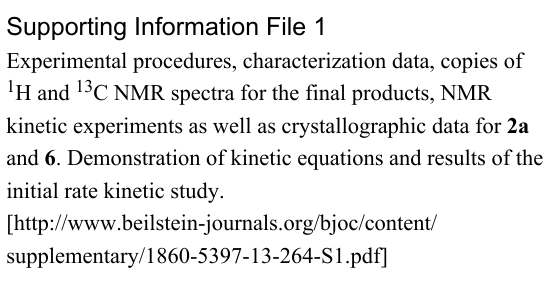
mined during C–C bond formation step. A diastereoselective streptopyrrolidine analogue, containing three contiguous stereo- genic centers, was smoothly obtained as a sole diastereomer in 70%